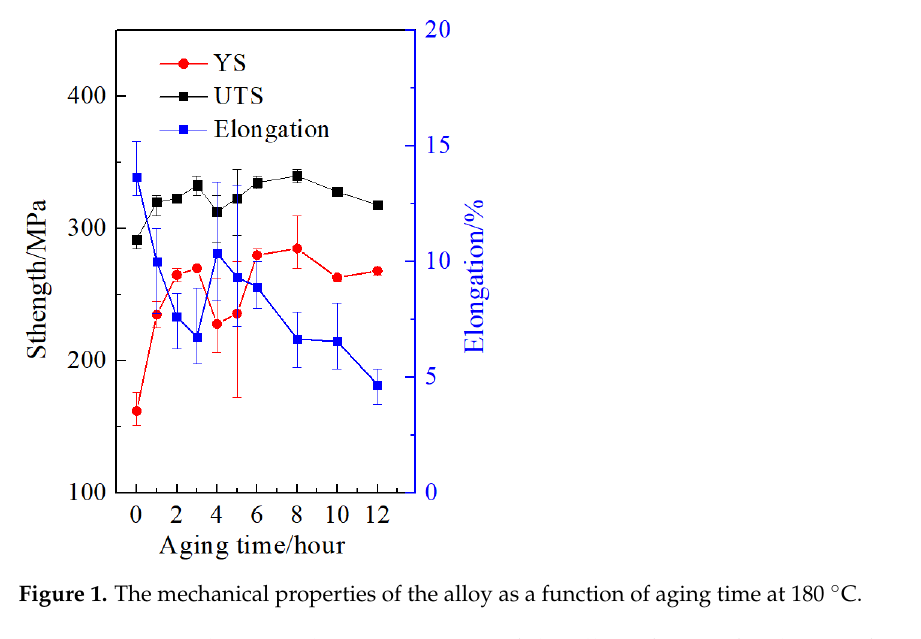
Figure 1. The mechanical properties of the alloy as a function of aging time at 180 °C.